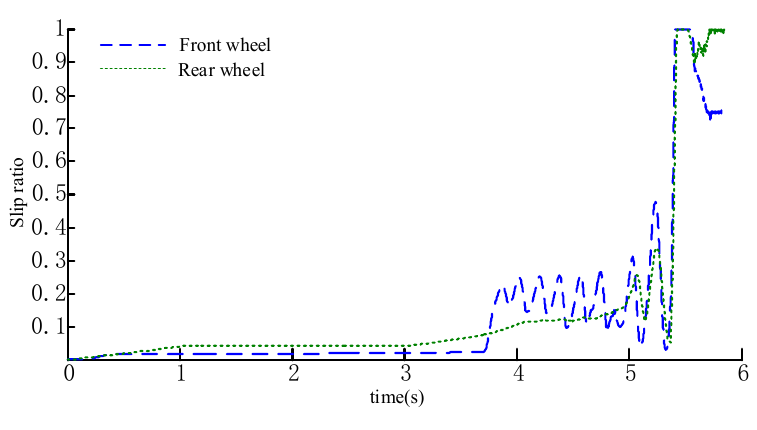
Figure 18. Slip ratio variation.